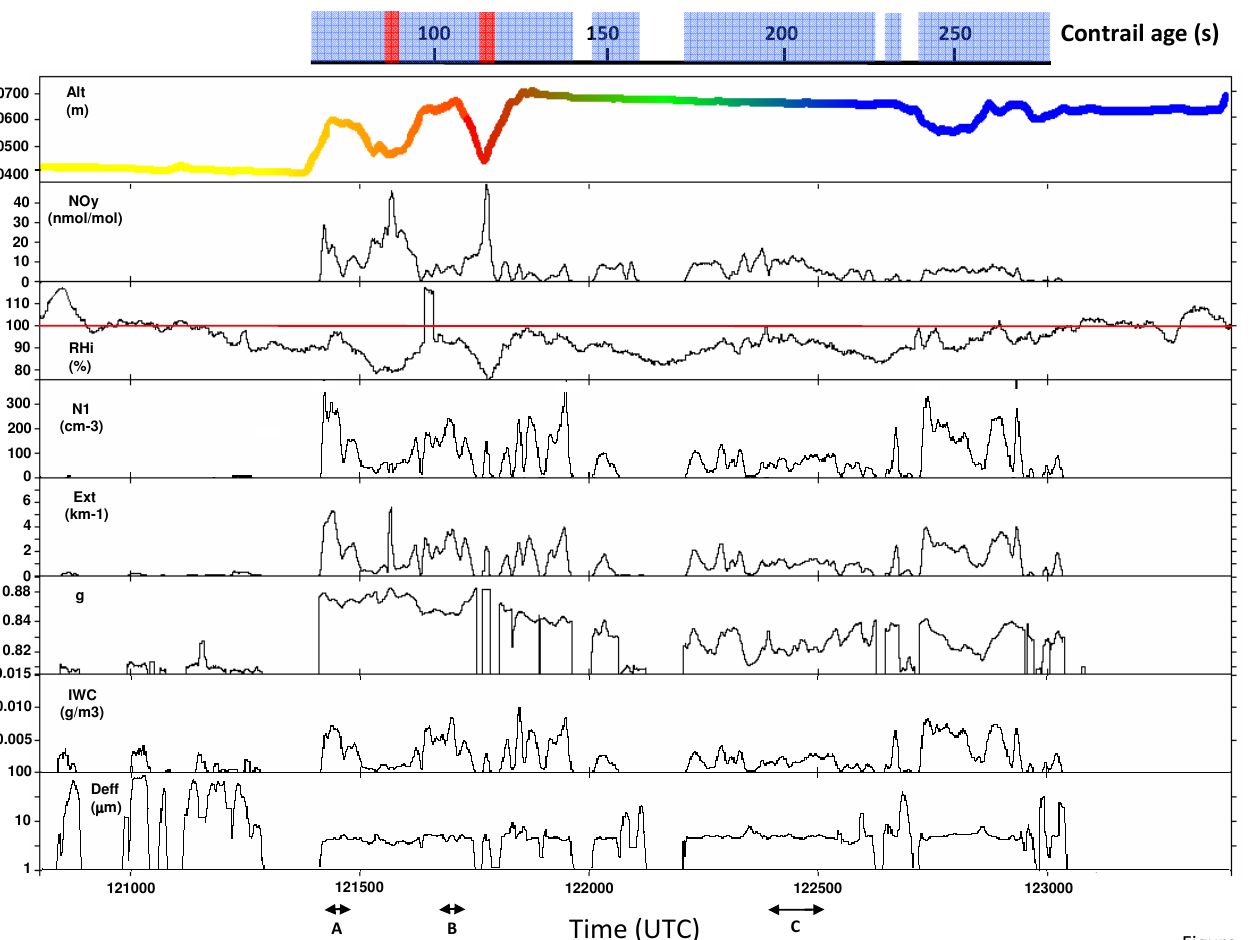
Fig. 2. Time-series at 1-s resolution of measured altitude, NO y mixing ratio, relative humidity with respect to ice (RH i ), concentrations of particles with diameter greater than 0.9µm ( N 1), extinction coefficient (Ext), asymmetry parameter ( g ), ice water content (IWC), and effective diameter ( D eff ). The top axis shows the separation time between the A380 and Falcon aircraft, indicating the A380 contrail age versus sampling time. The color shading of the altitude time-series reflects this contrail age. The red and blue shaded areas in the top bar represent sampling periods inside the primary and inside the secondary wake of the contrail, respectively. At the lower figure edge, arrows, labeled A, B and C, identify periods selected for retrieval analysis (see Sect.